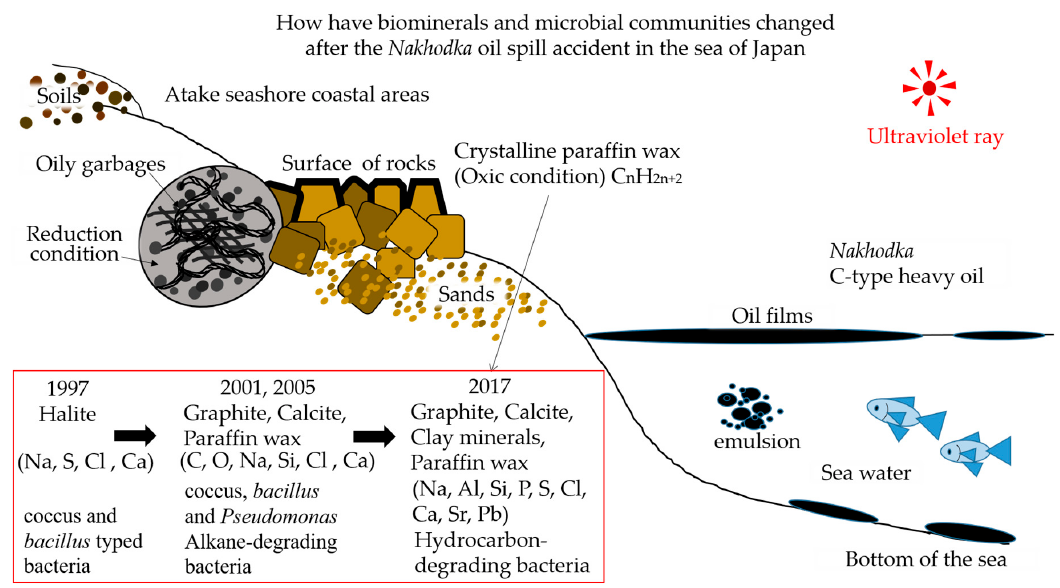
Figure 8. Illustrated schema of “How have contamination changed from 1997 to 2017”, 20 years after the Nakhodka heavy oil spill accident. The schematic diagram illustrates one possible mechanism of heavy oil contamination, depending on the oxidation or reduction